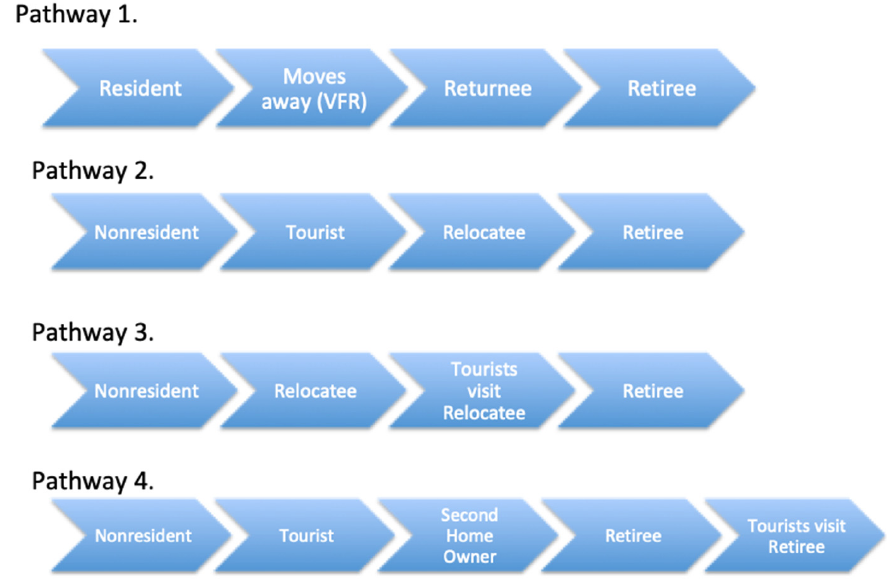
Figure 2. Sample market